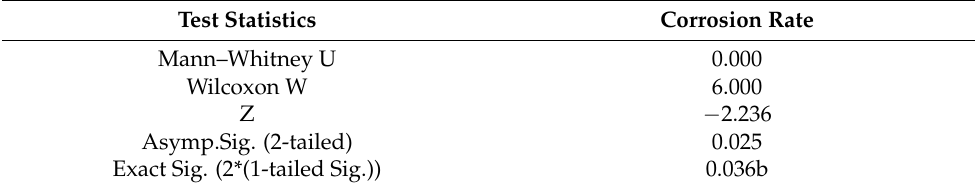
Table 4. Statistical analysis, corrosion rate (CR) SBF vs. In